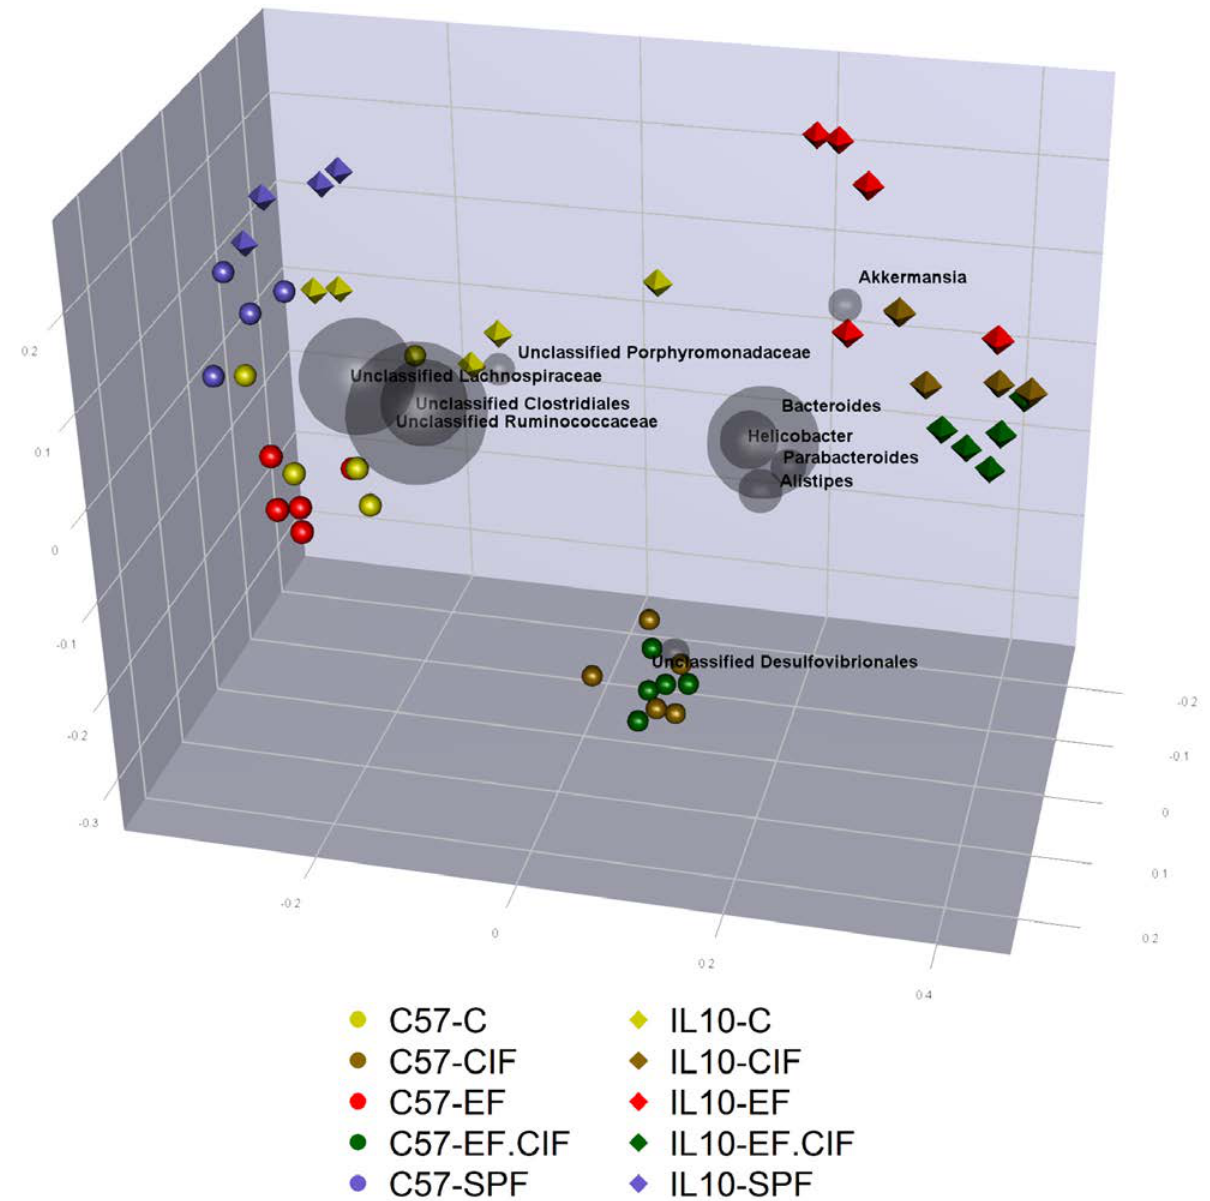
Figure 1. Principal coordinate analysis (PCoA) biplot of unweighted Unifrac phylogenetic distances between communities from C57 (spheres) and Il10 -/- (tetrahedrons) mice inoculated with EF, CIF, or EF.CIF, or un-inoculated mice housed in specific pathogen free (SPF) or conventional (C) conditions. Distances between points indicate phylogenetic similarity of communities, with more similar communities placed closer together. Grey spheres indicate the ten most abundant taxa and their contribution to the separation between communities. The size of the grey spheres represent their relative abundance across all communities and the placement indicates which communities have the highest abundance of these taxa: the closer the community is to the taxa, the greater the relative proportions that taxa makes up of the total microbiota in that